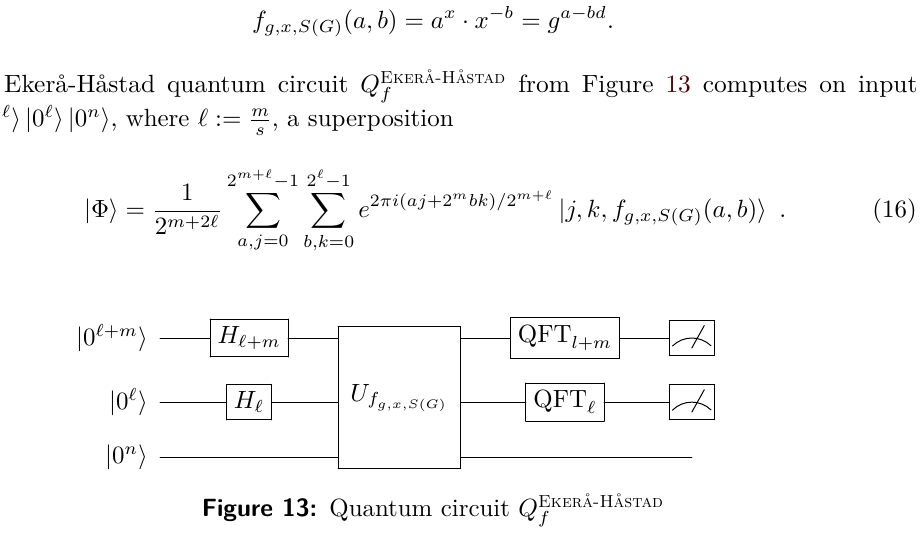
Figure 13: Quantum circuit Q Ekerå-Håstad